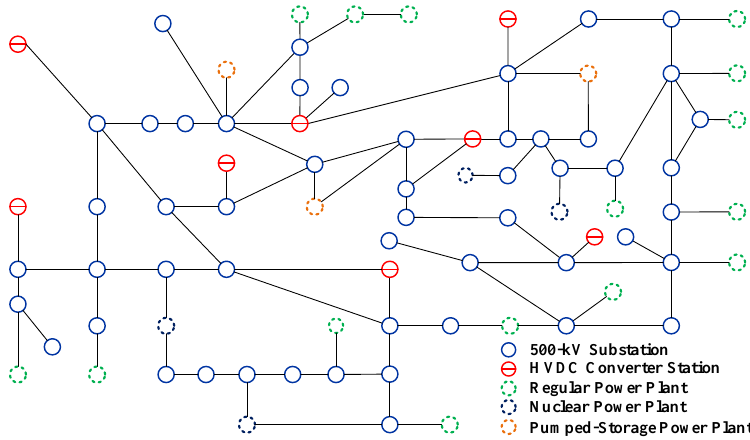
Figure 3. Structure of GD Power Grid in China (500-kV backbone